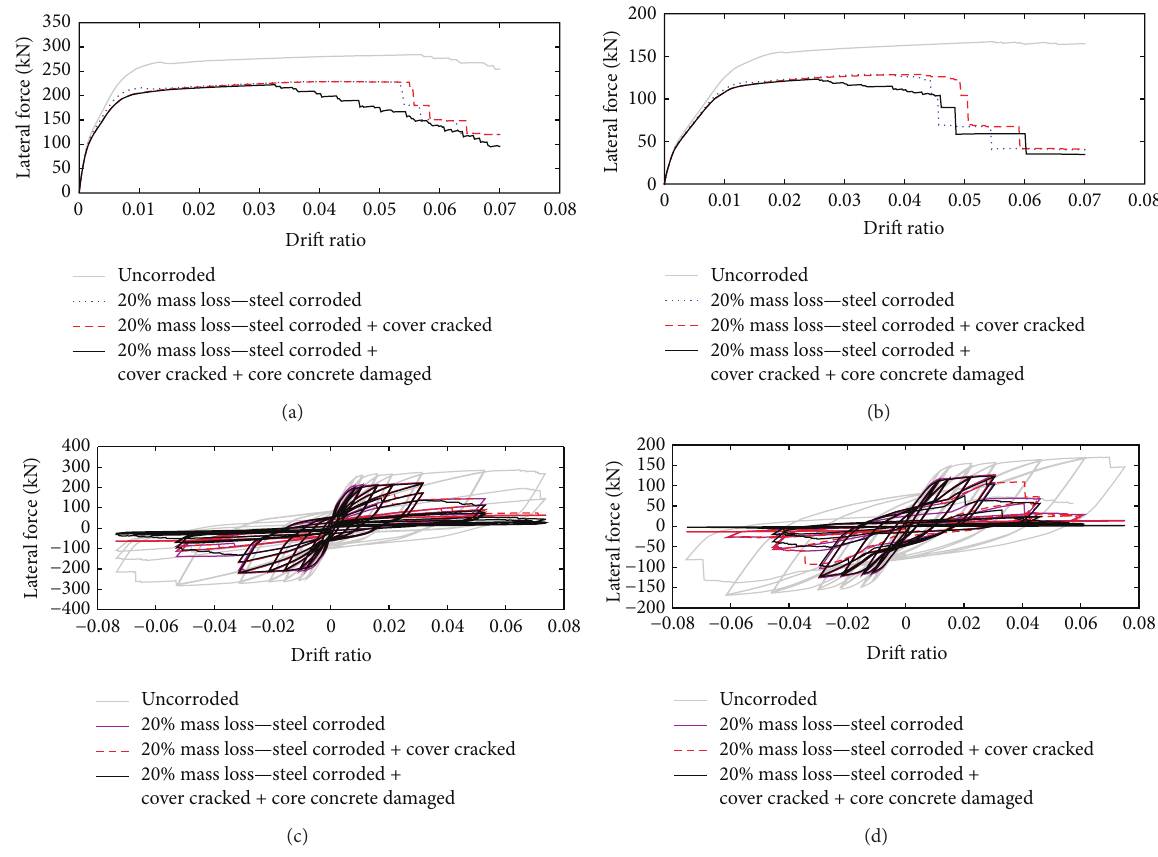
Figure 14: Comparison of the computed responses of columns with different deterioration models: (a) and (c) Lehman’s column 415 under monotonic and cyclic loading; (b) and (d) Moyer and Kowalsky’s column 1 under monotonic and cyclic